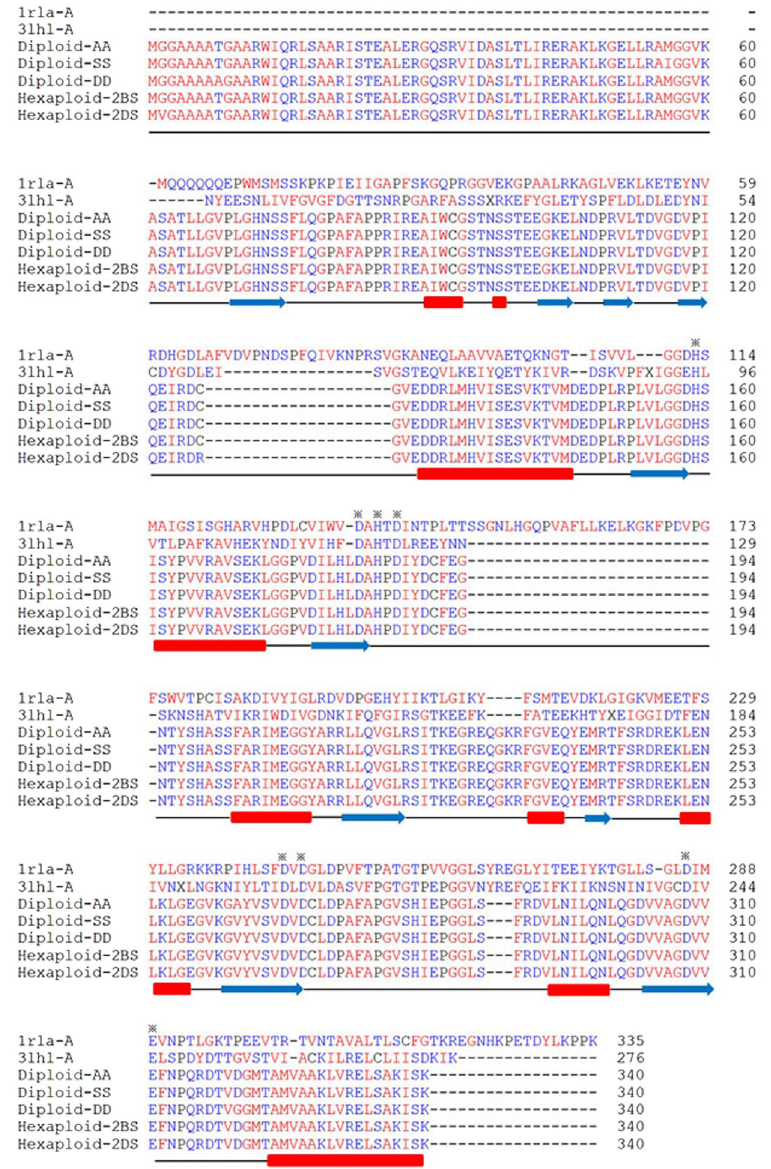
Figure 3. Alignment of ARG amino acid sequences from common wheat and its progenitor species. α -helixes and β -sheets are indicated by red rectangles and blue arrows, respectively. The asterisks indicate the functional conserved residues. The polar amino acid residues are shown in blue, and the remaining amino acids are shown in